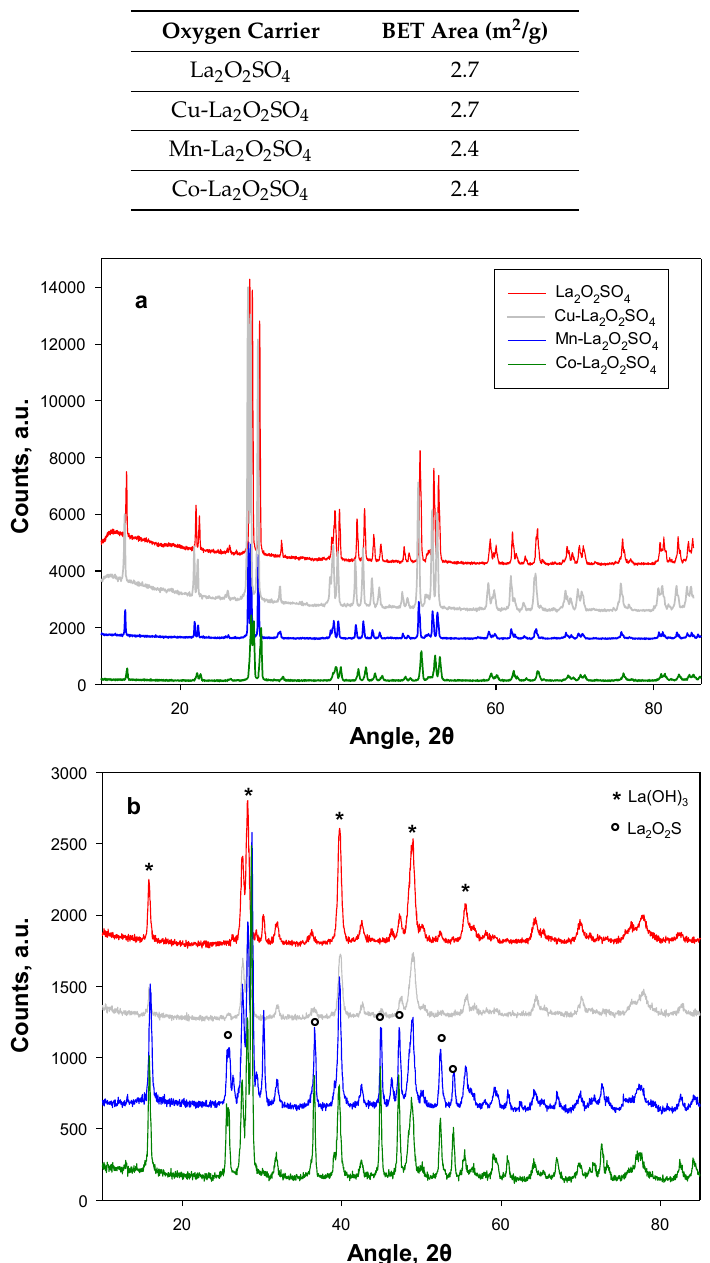
Table 1. List of oxygen carriers and corresponding values of Brunauer–Emmett–Teller (BET) surface area.